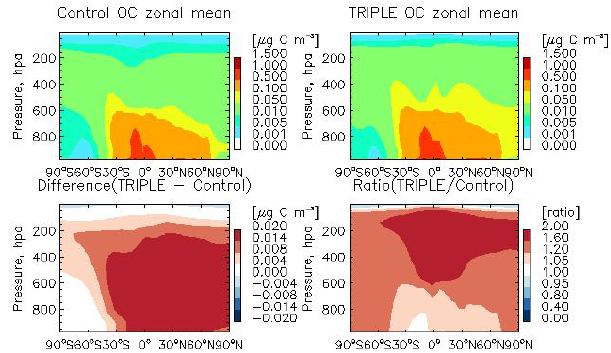
Fig. 9a. Scatter plots for annual mean BC between model simula- tion results and observations from IMPROVE, EMEP, CAWNET and remote sites. Black circles represent control simulation results, with TRIPLE, oxidation, condensation-coagulation and combined aging schemes are shown by purple, red, green and orange circles, respectively. Slope ( K ) and correlation coefficients ( R 2 ) between observation and control simulation are shown in each panel.